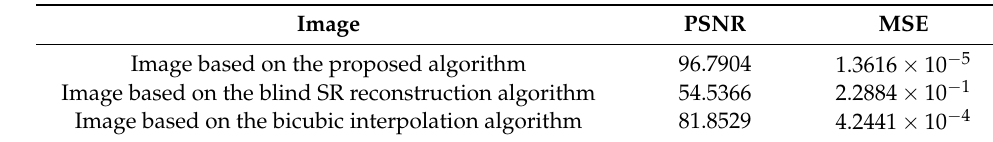
Table 4. Evaluation results of the experiment.